Question: What visual encoding does this figure use to show its data?
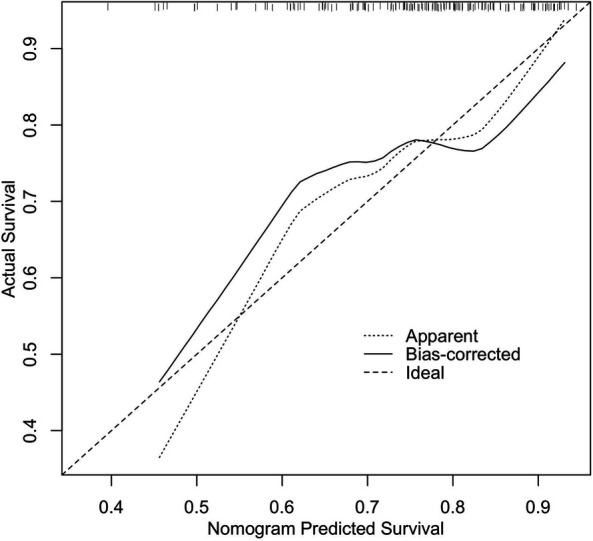
Answer: line